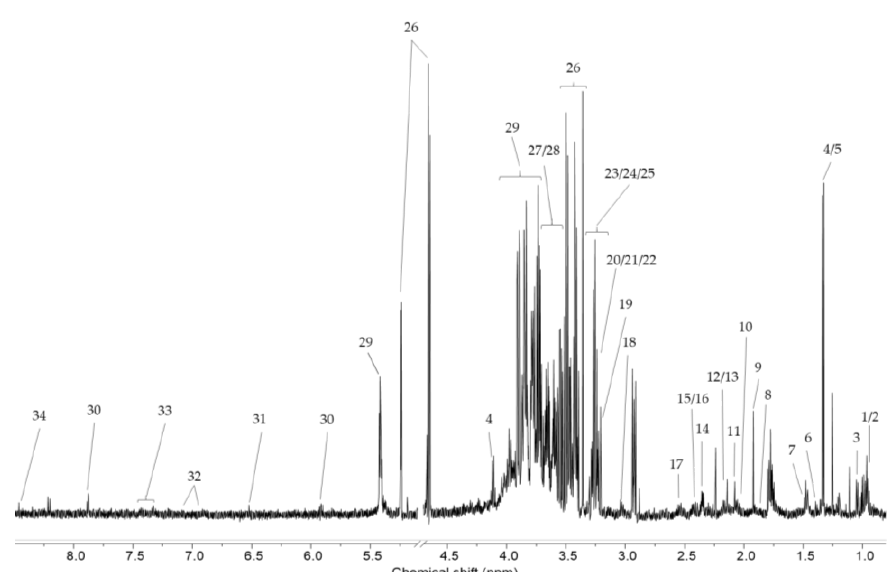
Figure 5. The representative 600 MHz 1 H-NMR spectra of rat liver extracts. Key: 1, isoleucine; 2, leucine; 3, valine; 4, lactate; 5, threonine; 6, acetoin; 7, alanine; 8, arginine; 9, acetate; 10, proline; 11, N-acetylglucosamine; 12, methionine; 13, 2-octenoate; 14, glutamate; 15, pyroglutamate; 16, glutamine; 17, glutathione; 18, dimethylamine 19, lysine; 20, choline; 21, O-phosphocholine; 22, carnitine; 23, sn-glycerol-3-phosphocholine; 24, betaine; 25, taurine; 26, trimethylamine N-oxide; 27, glucose; 28, glycerol; 29, glycine; 30, maltose; 31, fumarate; 32; tyrosine; 33, phenylalanine; 34, formate.